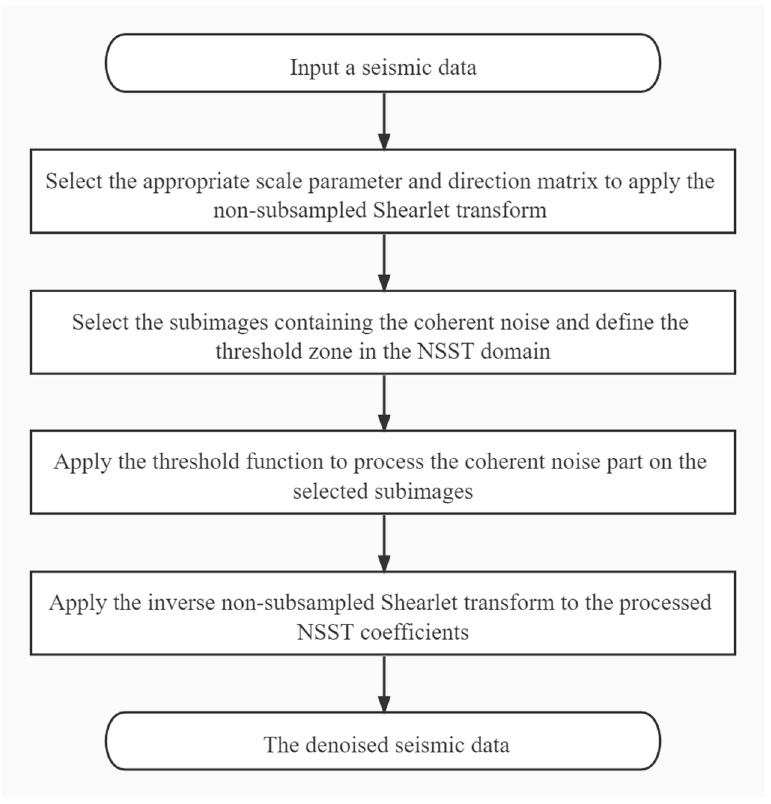
Figure 3. The flowchart of seismic coherent noise removal method in the NSST domain.